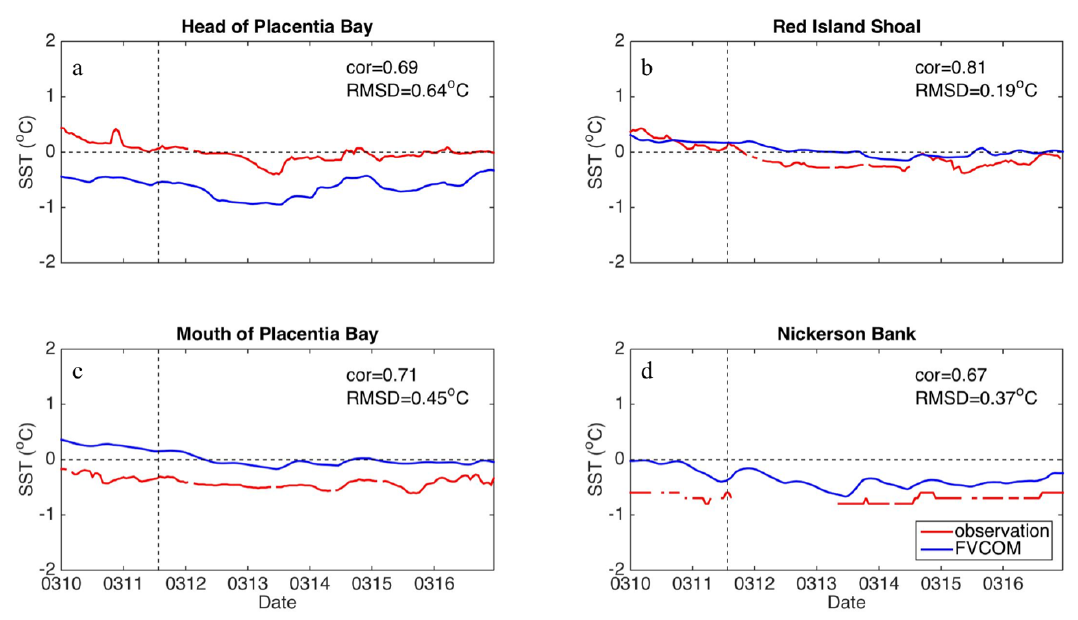
Figure 8. Comparison between buoys (red) and modeled (blue) sea surface SST at HP ( a ), RI ( b ), MP ( c ), and NB ( d ). The horizontal black dashed lines denote SST = 0 °C. The vertical black dashed lines denote the time of landfall.